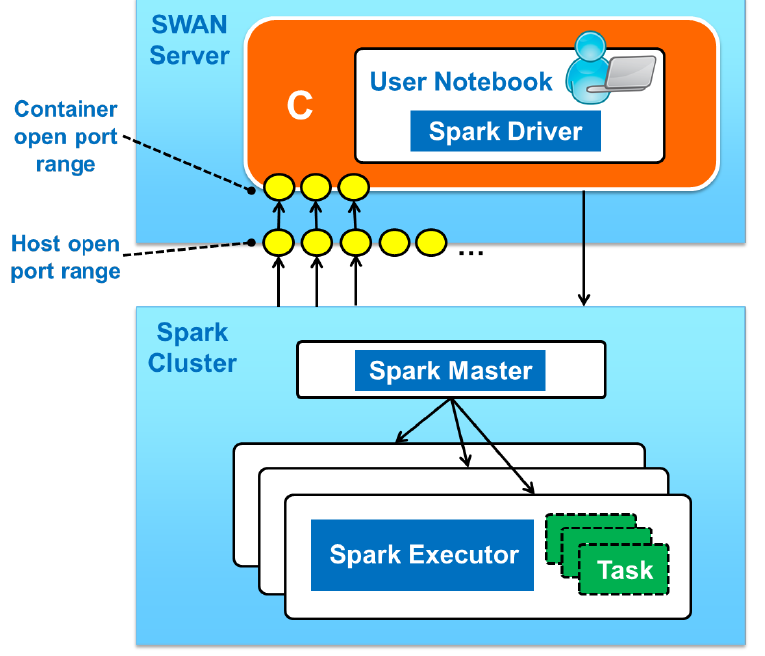
Figure 1: Interaction between SWAN server and Spark